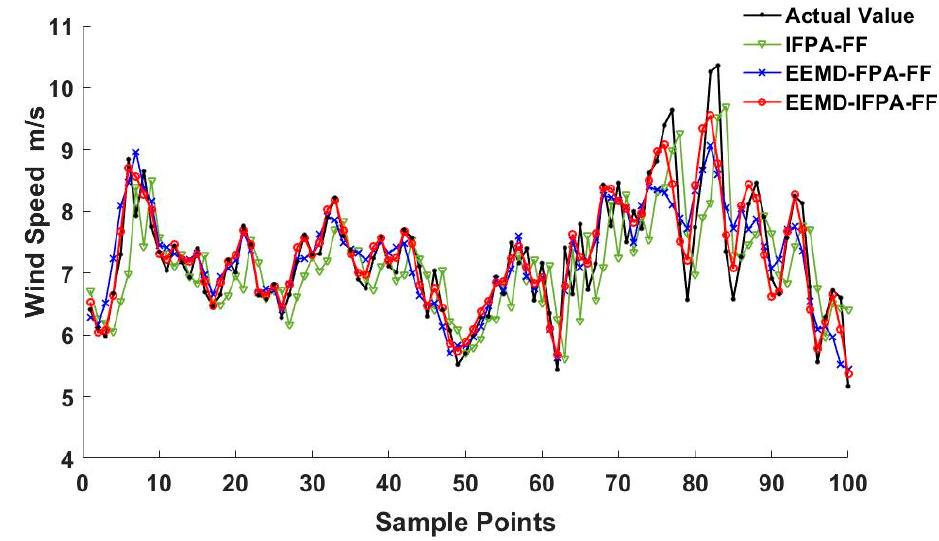
Figure 11. Wind speed prediction on 13 March.